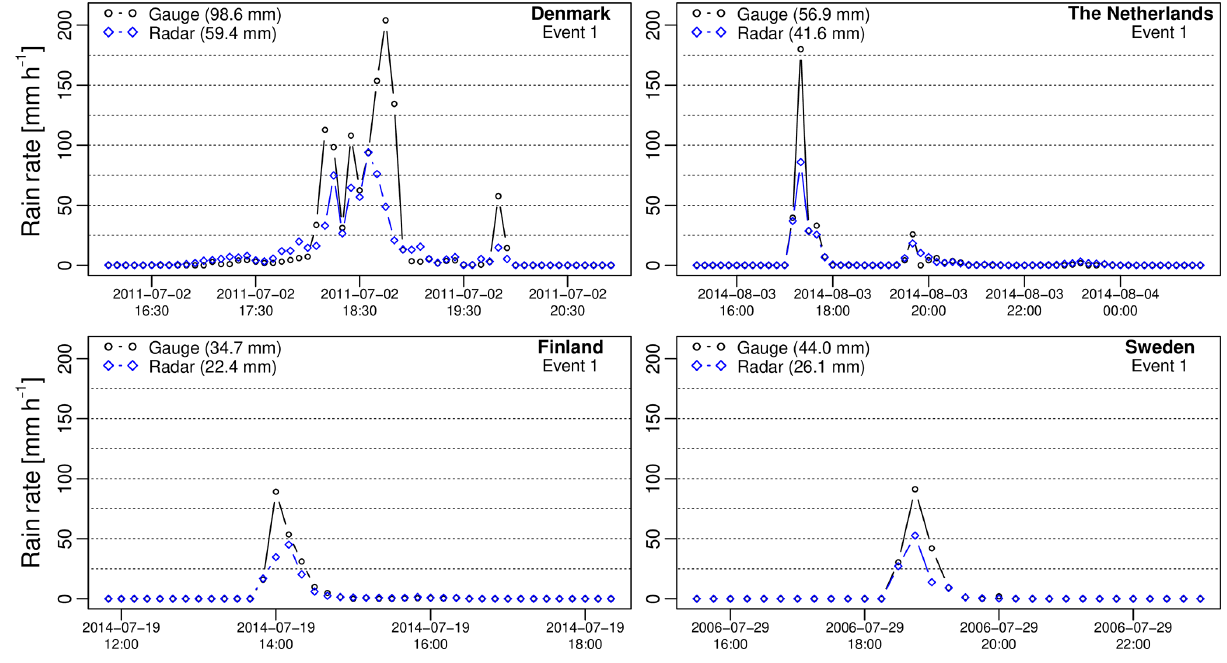
Figure 4. Time series of radar and gauge intensities (in mmh − 1 ) for the most intense event in each country.